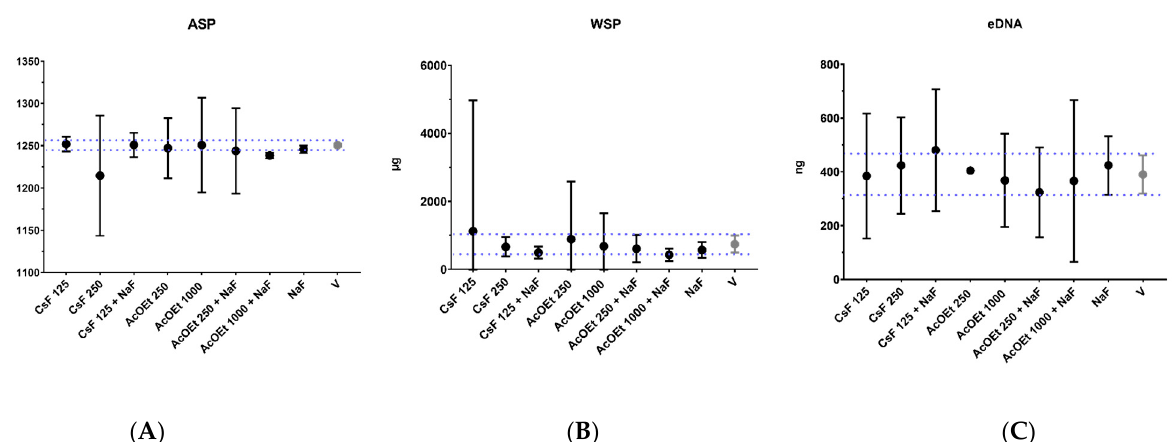
Figure 6. Components of the extracellular matrix of S. mutans biofilms after topical treatments. The graphs show the quantification of ( A ) ASP (µg), ( B ) WSP (µg), and ( C ) eDNA ( ƞ g) of biofilms (formed on sHA discs) after treatment with selected agents and controls. The central data are the mean, and the error bars are the confidence interval (95% CI). The dotted lines use vehicle data to compare the effectiveness of tested treatments. The vehicle control is represented as V (with the concentration being 21.04% EtOH and 3.75% DMSO for the AcOEt_BRA/DF fractions and 10.52% EtOH and 1.87% DMSO for CsF). The experiments for SPE-C18, AcOEt_BRA/DF, and CsF 125 µg/mL formulations were performed in duplicate on one experimental occasion ( n = 1) and duplicate on two separate occasions ( n = 2) for CsF 250 µg/mL.